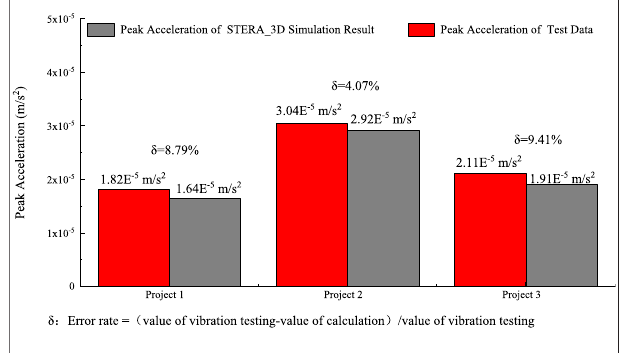
FIGURE 10 | Comparison of peak acceleration for the SPCC fl oating foundation